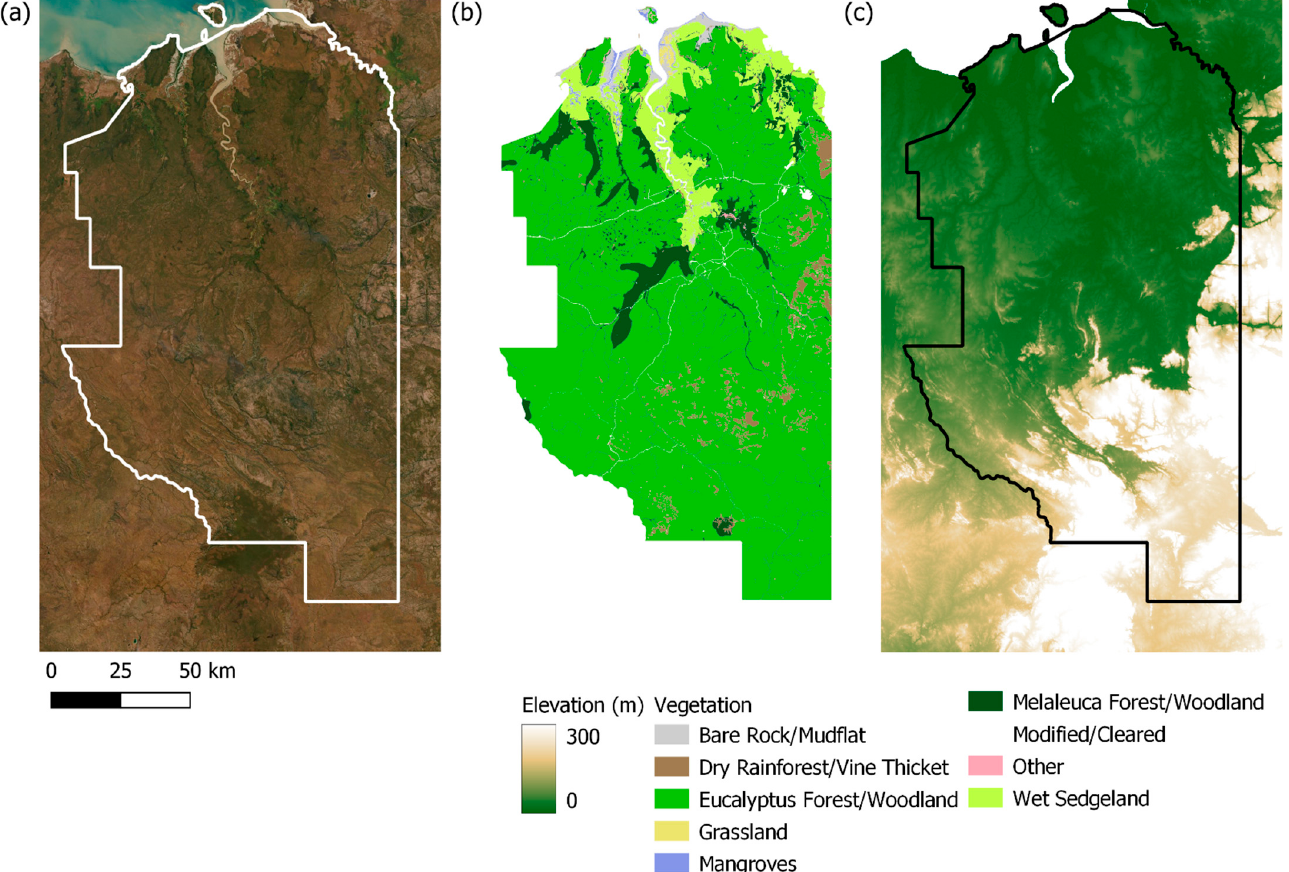
Figure 1. ( a ) Boundary of Kakadu National Park over true-colour satellite image (ESRI World Imagery), ( b ) Broad vegetation types within the park boundary and ( c ) Elevation, showing rocky upland areas in the south-east of the park of the western edge of the Arnhem Plateau.